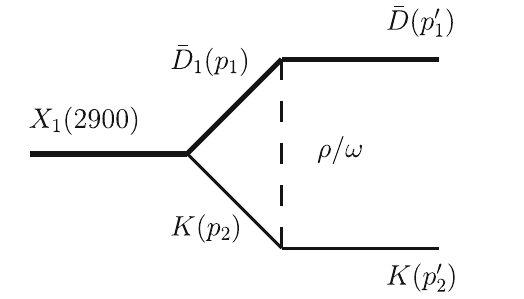
Fig. 3 The diagrams contributing to the X 1 ( 2900 ) → D − K + decay process induced by ρ and